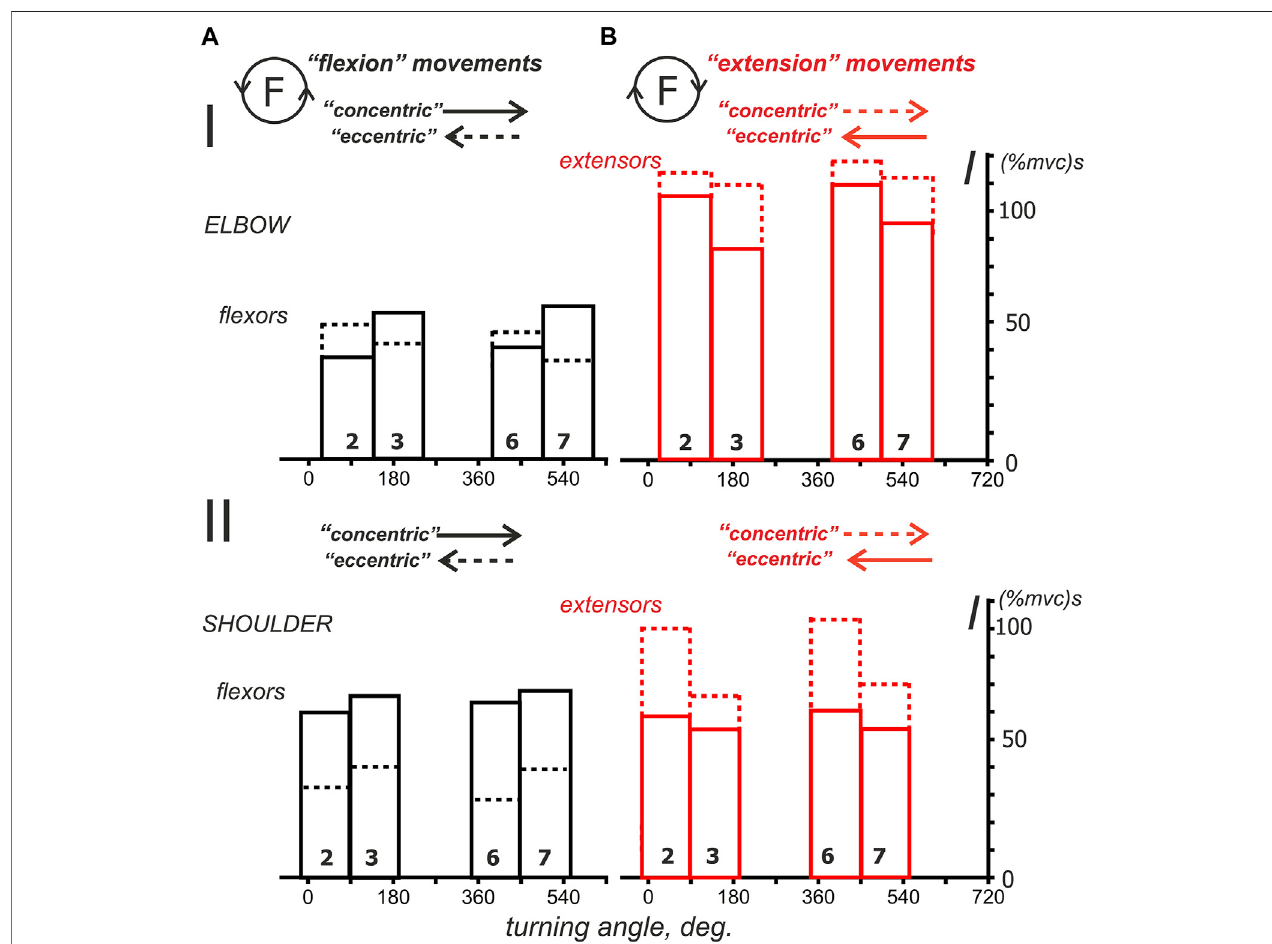
FIGURE 10 | The average integral EMG characteristics considered for predominantly activated muscles during the “ fl exion ” (A) and “ extension ” (B) movement paradigms. These reduced plots are extracted from the corresponding diagrams in Figure 9 ; the reactions of the antagonist muscles in these plots (extensors in A; fl exors in B) are hidden for simplicity. Note the rotation of the “ concentric ” and “ eccentric ” directions for the fl exor and extensor muscles.